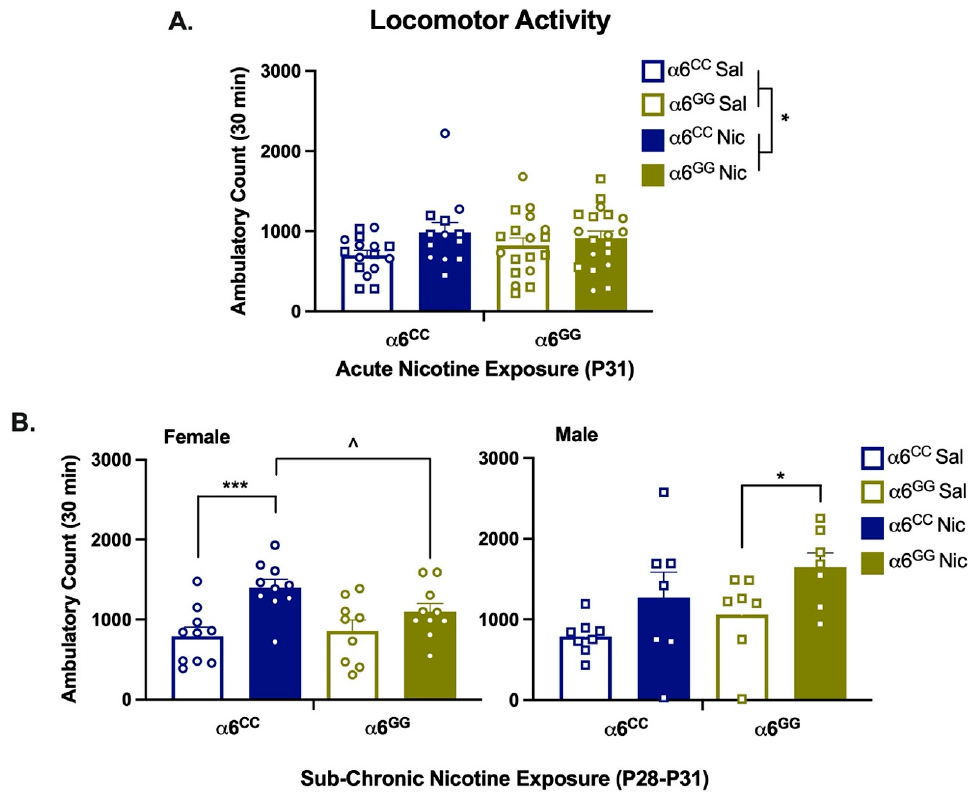
(cid:48) -UTR SNP rats. Mean total ambu- Figure 3. Nicotine-induced locomotion in humanized CHRNA 6 3 ′ -UTR SNP rats. Mean total Figure 3. Nicotine-induced locomotion in humanized CHRNA6 3 latory counts ± SEM for ( A ) 1-day nicotine exposure, collapsed by sex n = 13–19/group. ( B ) 4-day nicotine exposure, * p < 0.05, *** p < 0.001 Nic vs Sal; ˆ p < 0.05 α 6 CC Nic vs α 6 GG Nic n = 7–10/group. Saline (Sal), Nicotine (Nic). Circles represent females, and squares represent